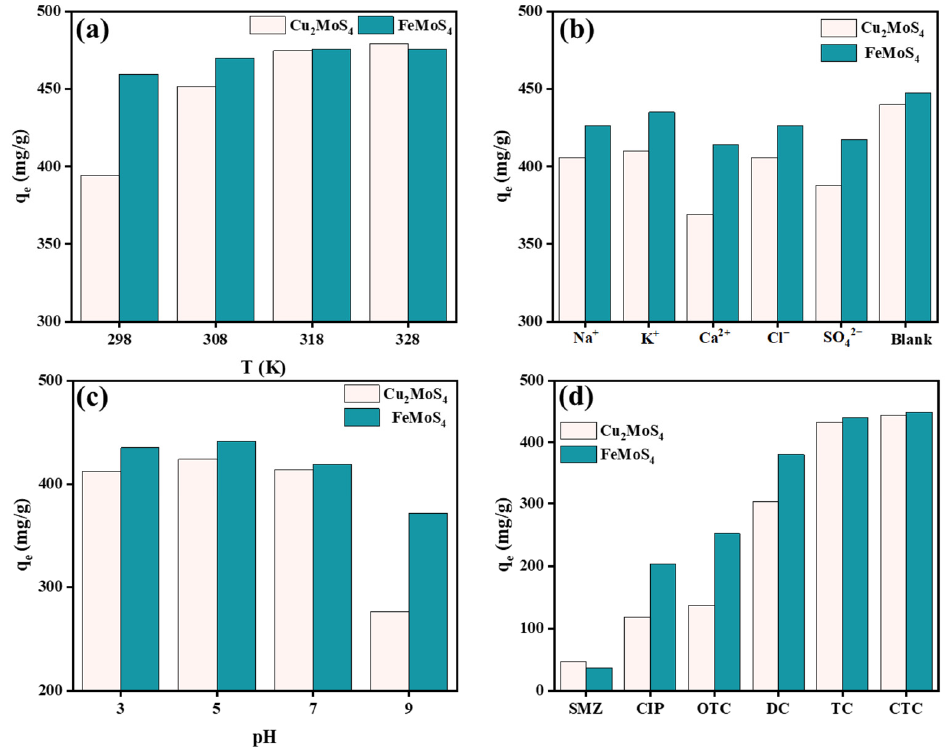
Figure 7. Effect of ( a ) temperature, ( b ) solution coexisting ions, ( c ) pH, and ( d ) antibiotic contaminants on adsorption capacity (C sorbent = 0.5 g/L, C 0 = 100 mg/L). Table 4. Adsorption thermodynamic parameters.